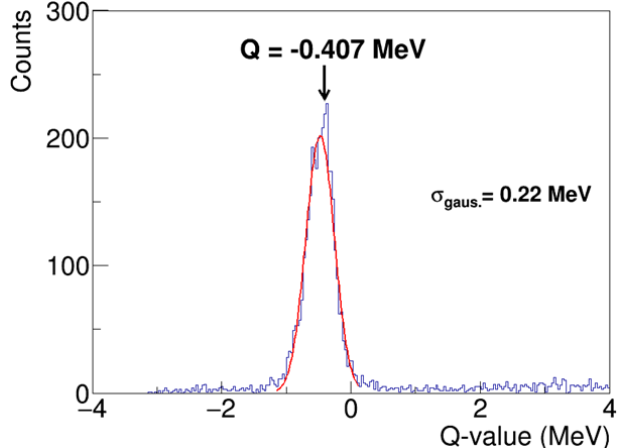
Figure 3. Experimental Q-value spectrum for the 2 H ( 17 O ,α 14 C ) H reaction, the arrow marks the theo- retical value, while the red line is a gaussian fit of the histogram with σ g aus . = 0 . 22 MeV